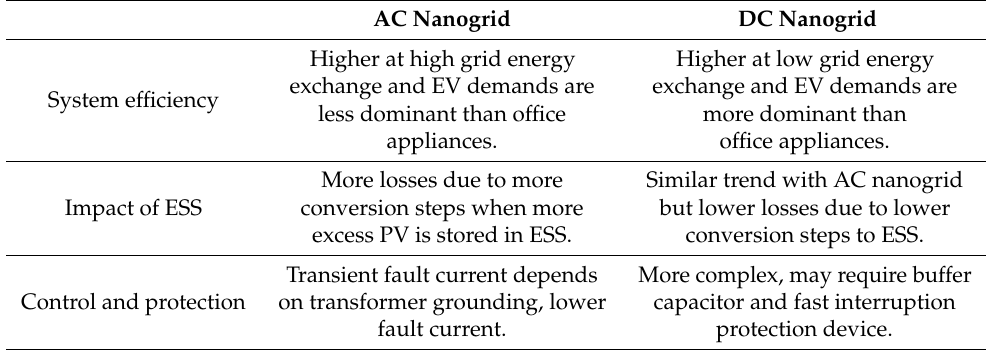
Table 5. AC and DC nanogrid